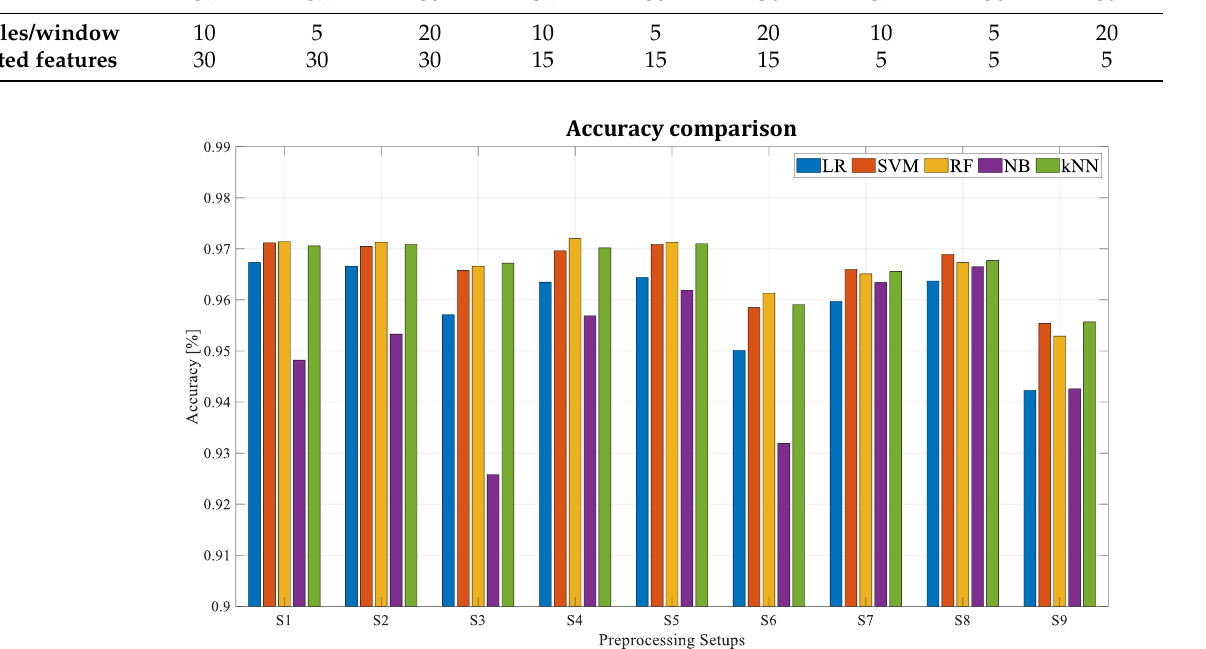
Figure 9. F-1 score for different algorithms and dataset configurations. All the scores with the different pre-processing configurations improve 90% of accu- racy. However, the setups where the window length for feature extraction is composed of 20 samples (Set 3, 6, and 9) are the worst setups. This is because by trying to compress the information of N points into just one, some of the information is lost unintentionally. Therefore, the higher the value of N, the less information is transmitted to the algorithm